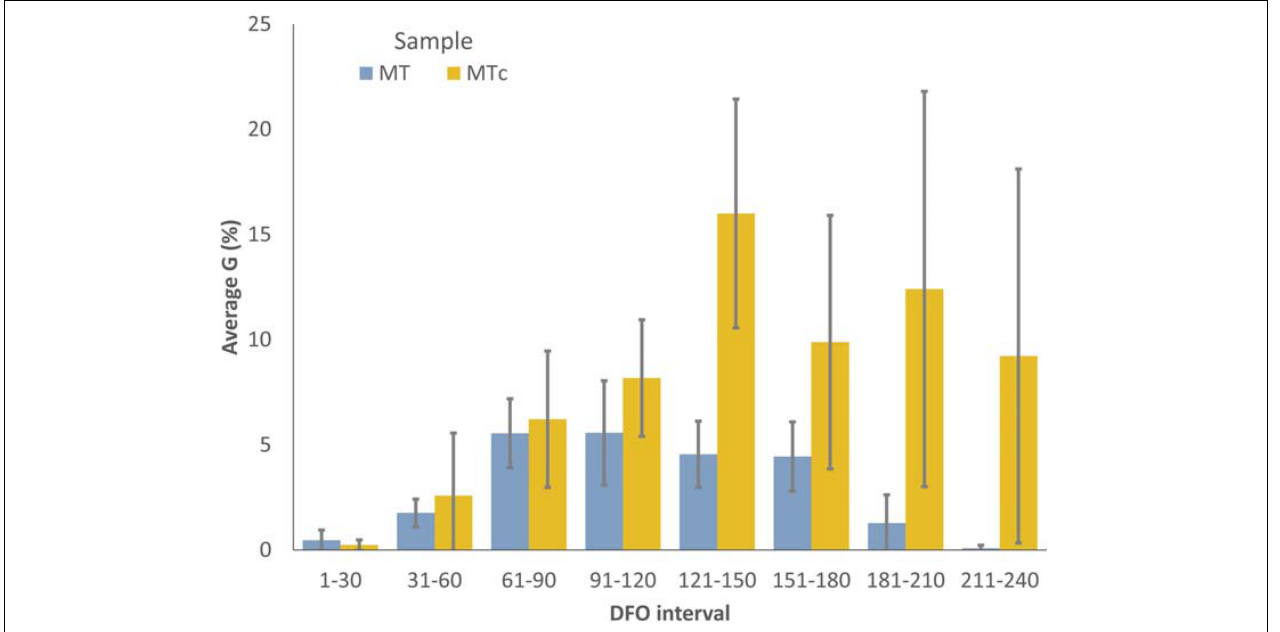
FIGURE 1 | Average germination percentages of MT (blue) and MTc (yellow) samples at different DFO intervals. Bars represent 95%